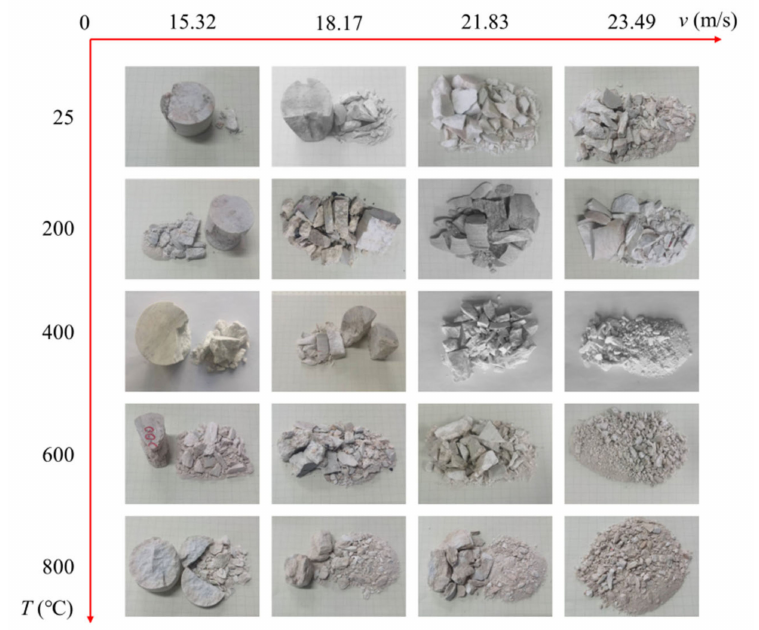
Figure 11. Failure mode of marble after high